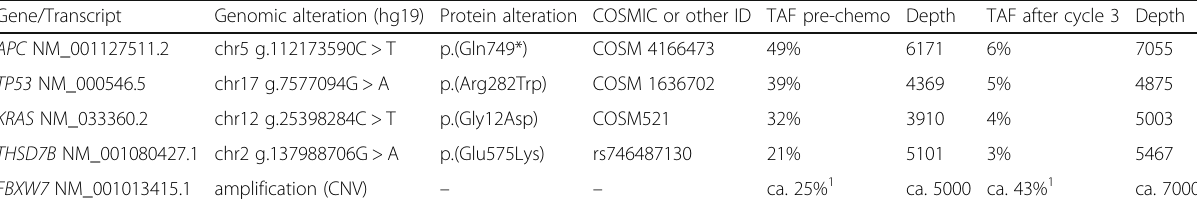
Table 1 Plasma cell free DNA tumour molecular genetic results in HGVS nomenclature, with tumour allele frequency (TAF) and sequence depth at mutation